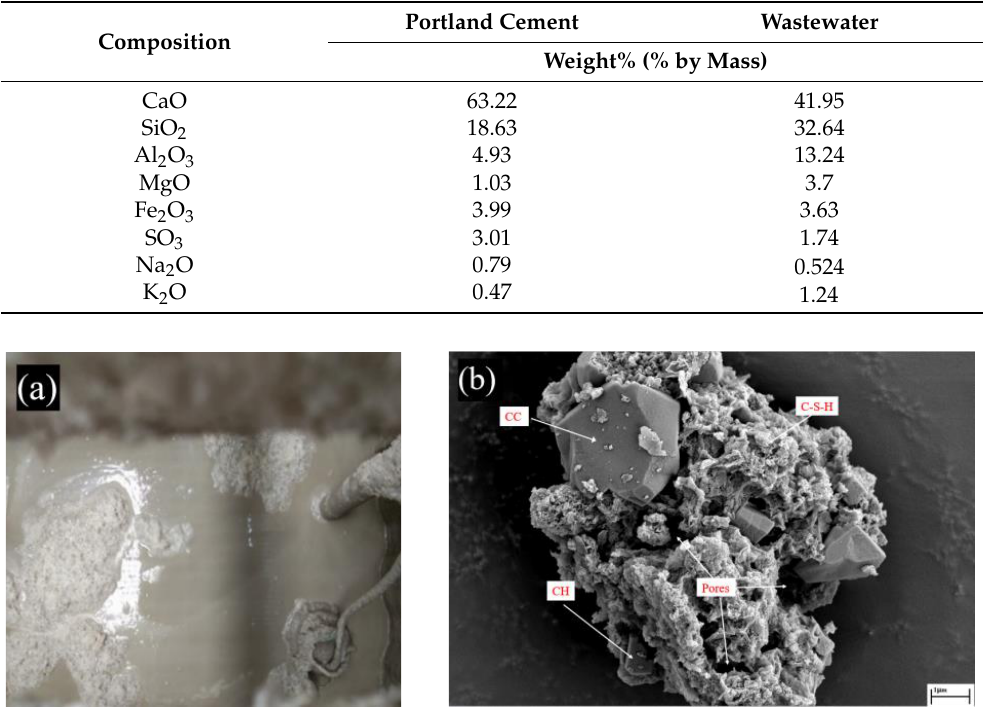
Figure 3. ( a ) Wastewater; ( b ) 8000 times magnified photo of wastewater particles. C-S-H = calcium silicate hydrate, CH = Ca(OH) 2 , CC = CaCO 3 . Table 2. Chemical characteristics of wastewater and cement.